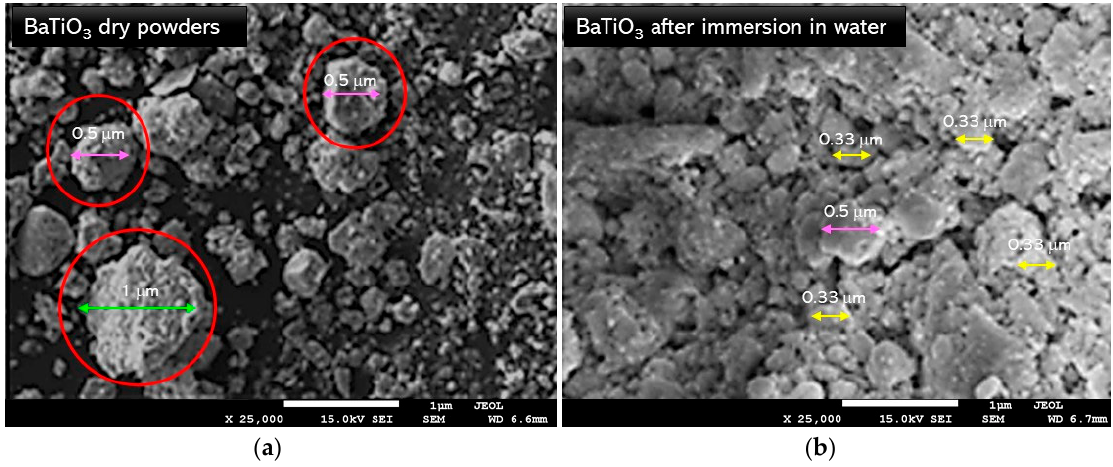
Figure 5. SEM microphotographs of mechanochemically obtained BaTiO 3 powders in dry state ( a ) and after immersion in water ( b ).